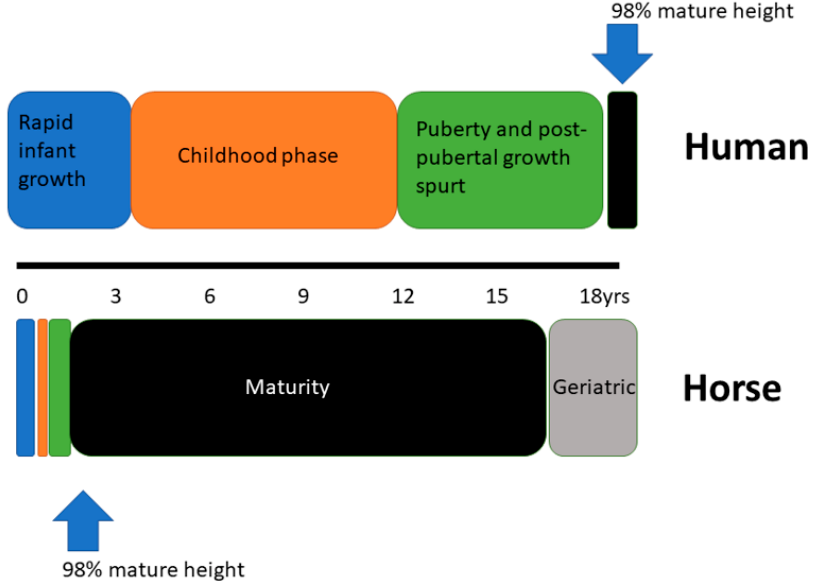
Figure 3. Schematic representation of the three periods of growth in human and equine development and the relative age at attainment of skeletal maturity.